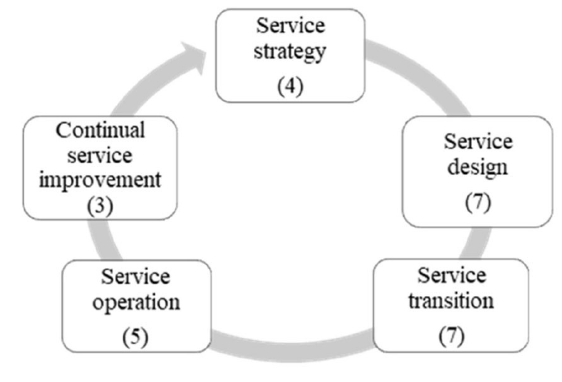
Figure 1. ITIL lifecycle